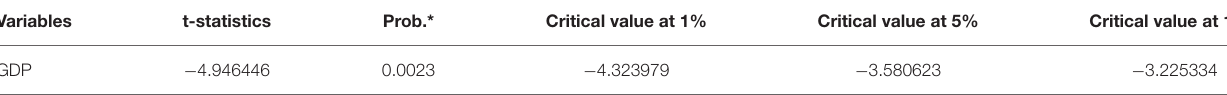
TABLE 3 | ADF unit root test in second-order difference.